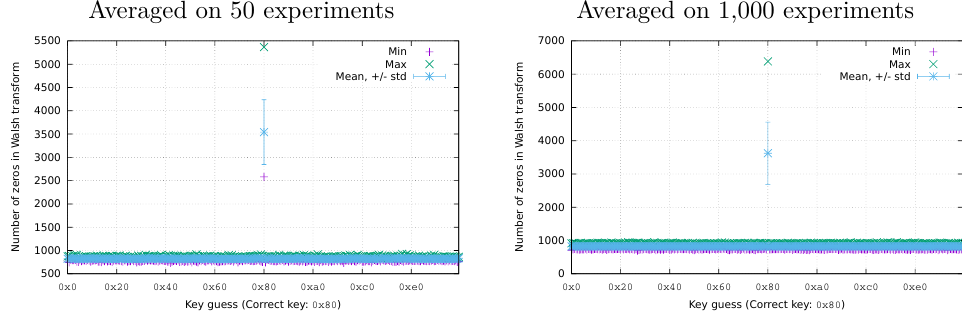
Figure 4: Number of zeros of Walsh spectrum of A k when sampling Walsh transform by byte component (correct key k ? = 0x80 is in the middle).